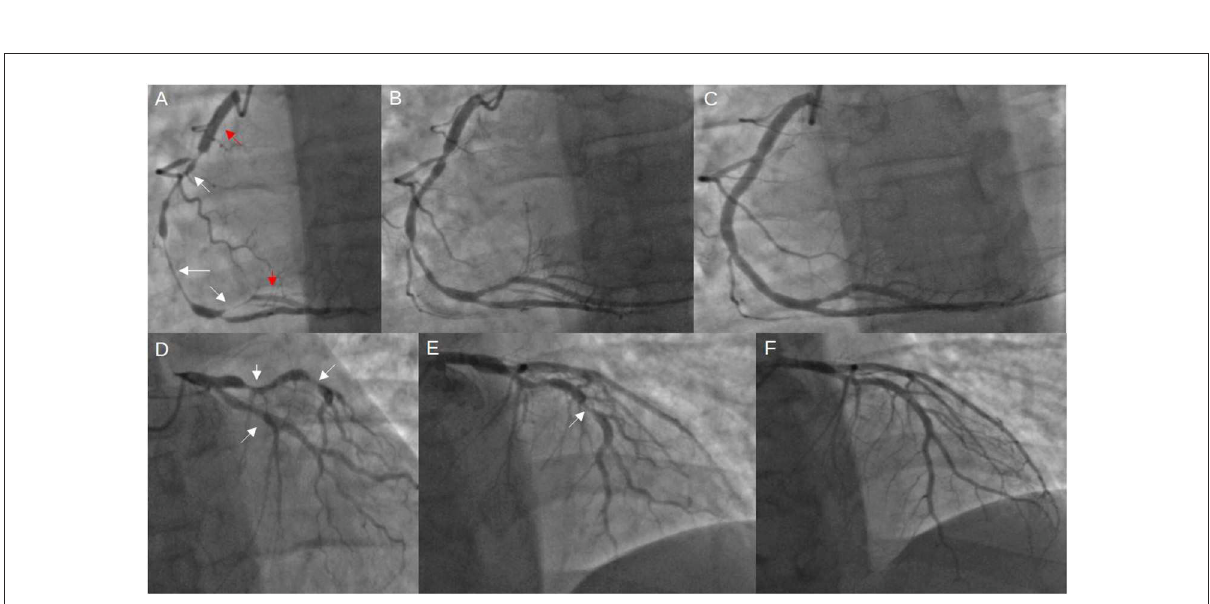
FIGURE4 Coronary angiogram from the current stay. (A) severe diffuse RCA spasm (indicated by the white arrows), previously implanted stents (red arrows); (B) improved RCA spasm after intracoronary injection of 300 mcg nitroglycerine; (C) further resolution of vasospasm after administering additional 100 mcg nitroglycerine and 2.5mg verapamil; (D, E) visible vasospasms in both LCx and LAD; (F) vasospasm resolution after 100 mcg nitroglycerine and 2,5mg verapamil intracoronarily (LAD, left anterior descending artery; LCx, left circumflex artery; RCA, right coronary